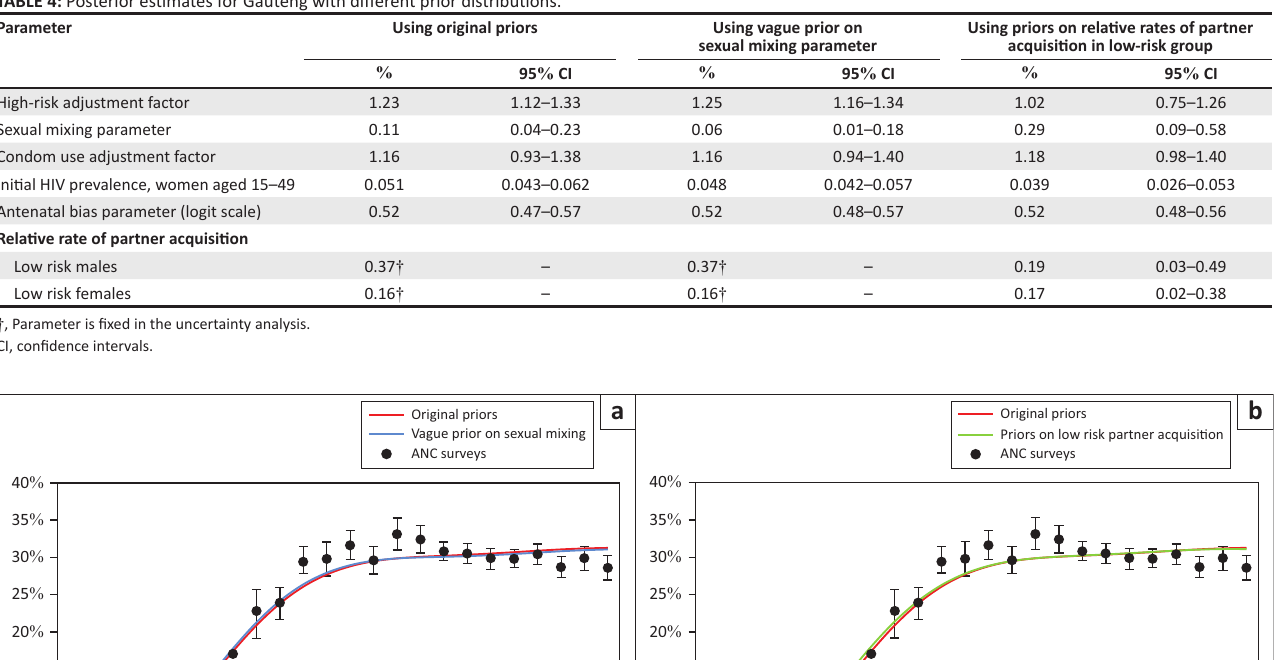
sexual mixing parameter